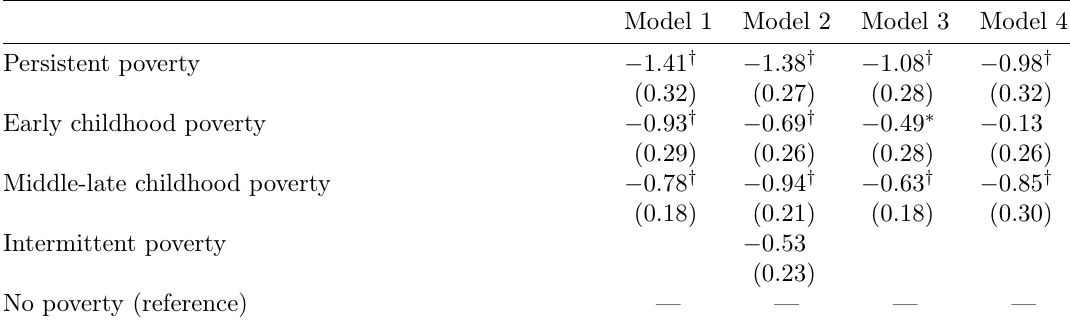
Table 6: Effect of Poverty Trajectories on High School